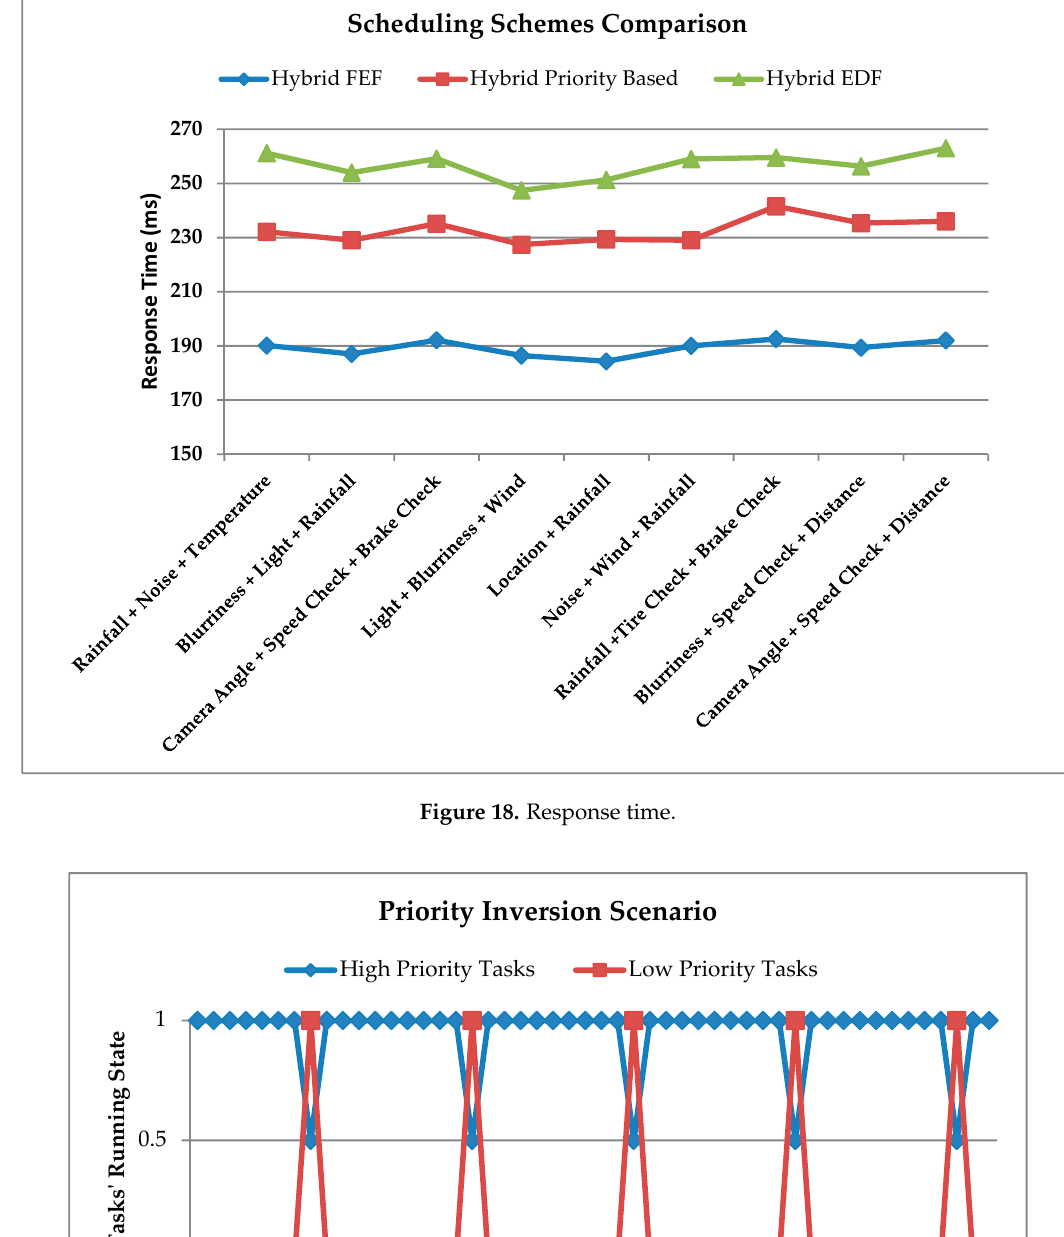
Figure 19. Increasing tasks’ load and priority inversion scenario.